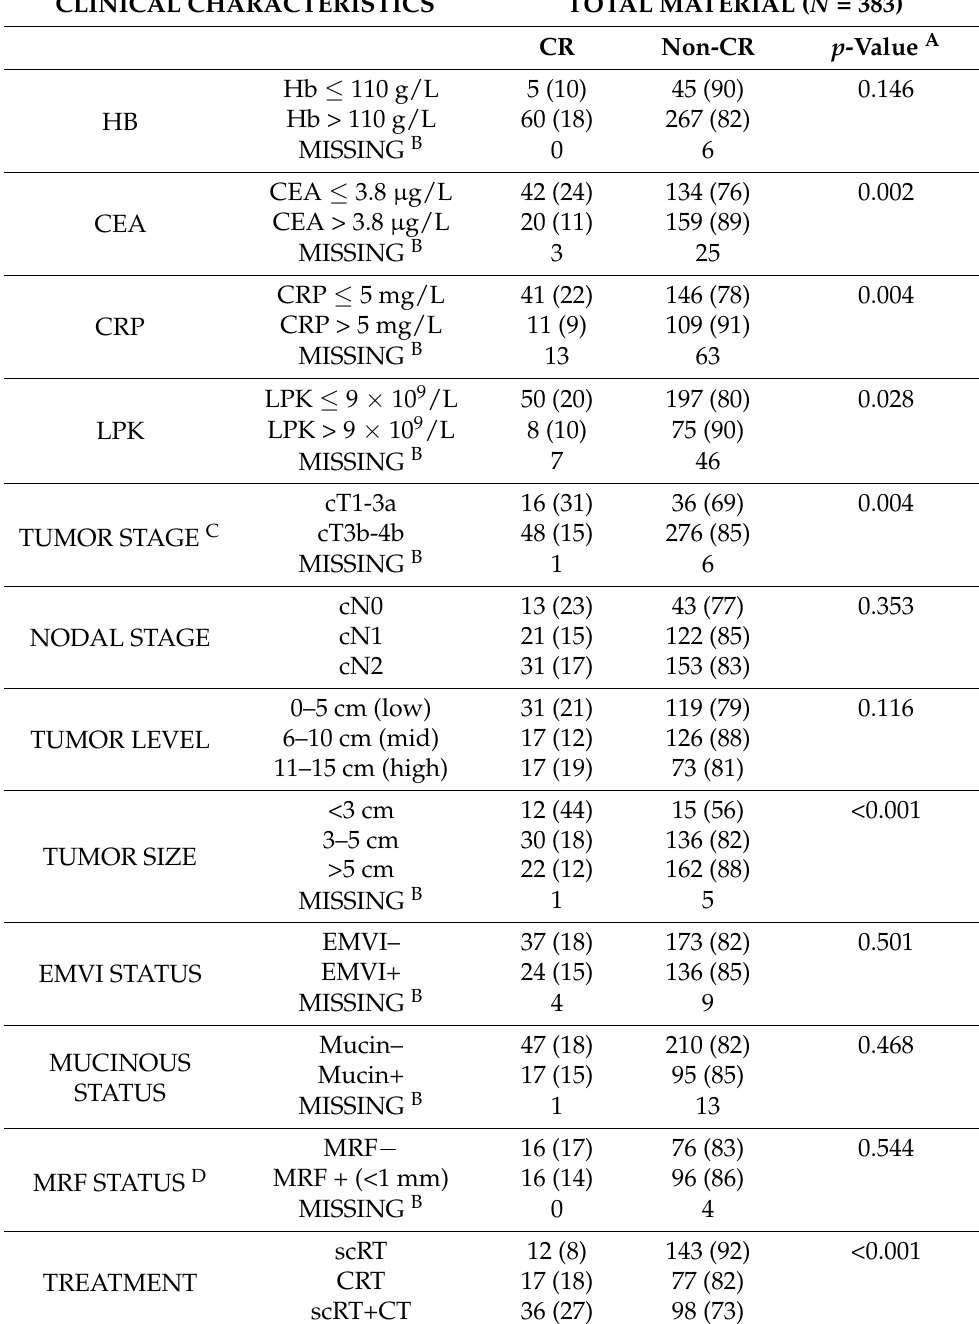
Table 3. Laboratory, clinical and MRI parameter’s association to treatment response in the entire study